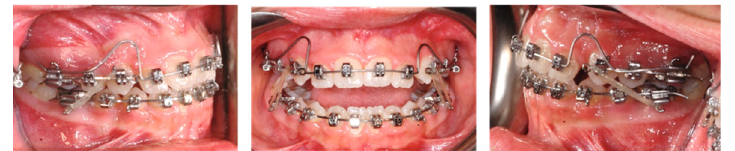
Figure 6: Translation utility arch (TRUA).